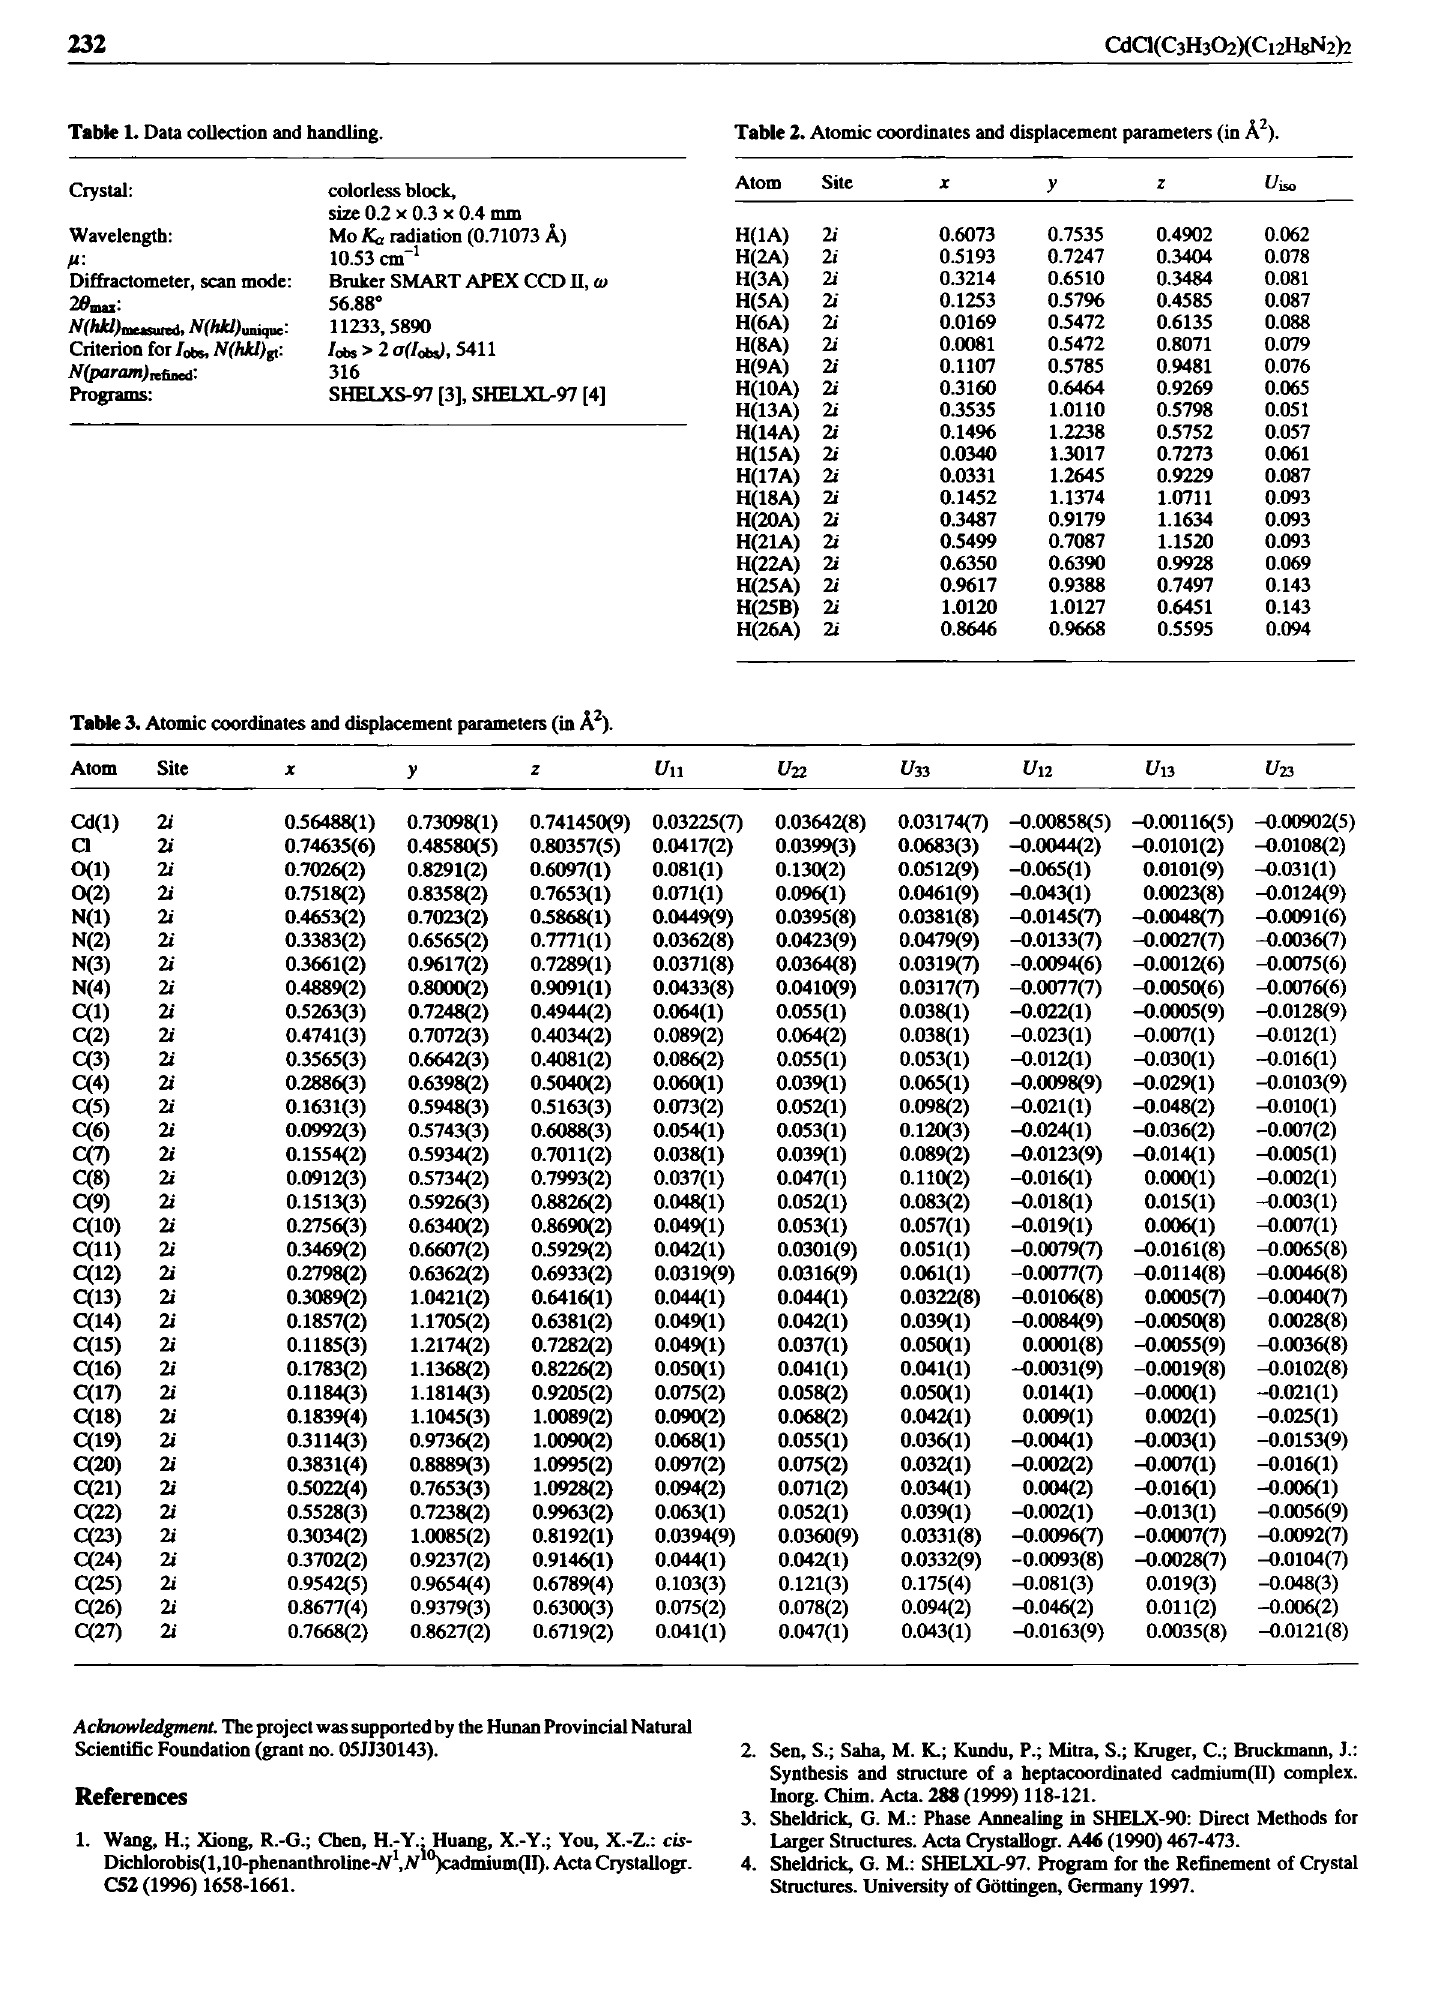
Table 1. Data collection and handling. Table 2. Atomic coordinates and displacement parameters (in Ä 2 ).